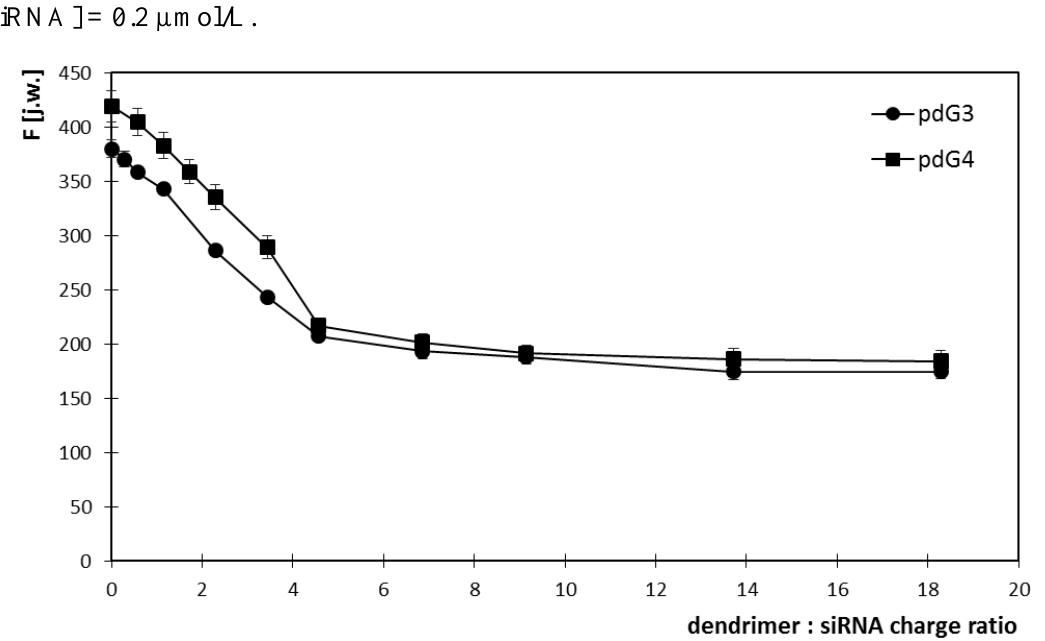
Figure 3. Changes in the intensity of ethidium bromide fluorescence vs the concentration of phosphorus dendrimers generation 3 (pdG3) and 4 (pdG4) at 588 nm. [EB] = 5 μmol/L [siRNA] = 0.2